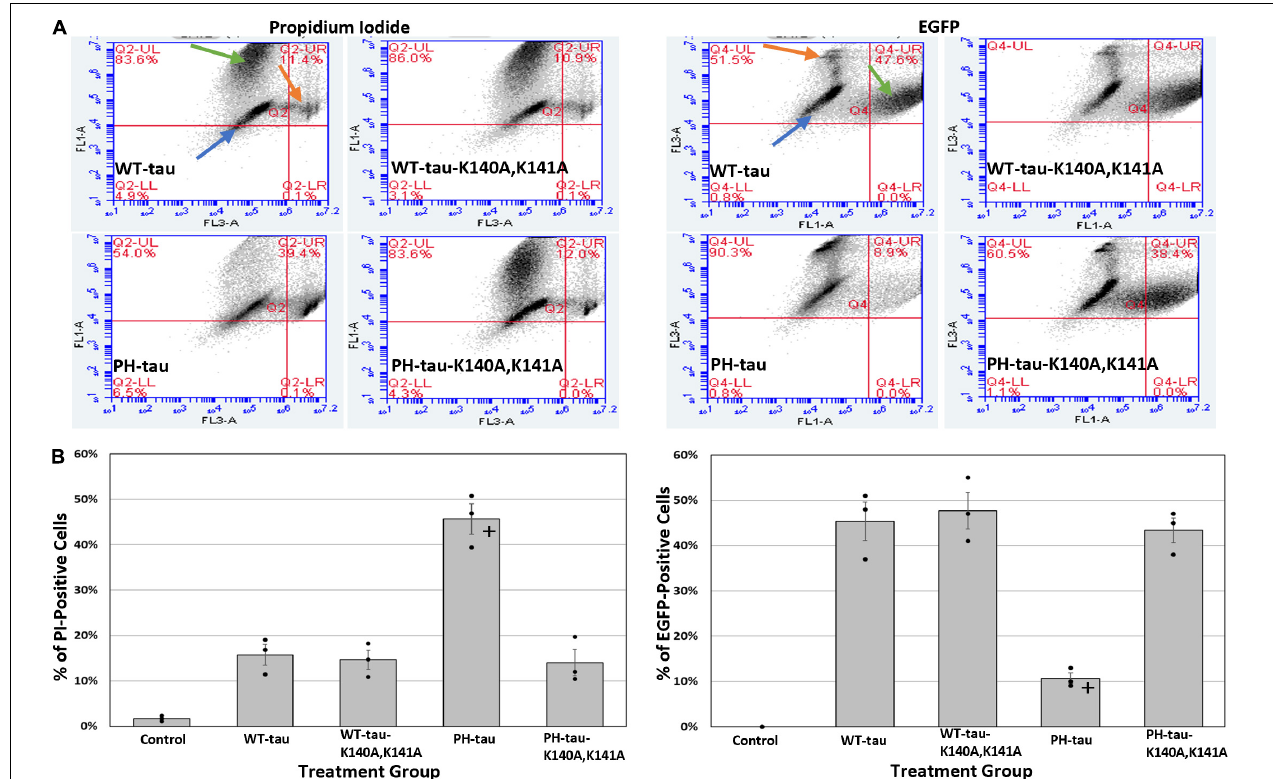
FIGURE 3 | Translocation of PH-tau into the nucleus promotes cell death. (A) Graphs indicating the percentage of cells that are PI-positive (left set of four) or EGFP-positive (right set of four) 24 h after transfection with WT-tau, PH-tau, WT-tau-K140A,K141A, or PH-tau-K140A,K141A. Orange arrows indicate the population of PI-positive cells, green arrows indicate the population of EGFP-positive cells, and blue arrows indicate the population of cells that is neither EGFP-positive nor PI-positive. (B) The percentage of events (i.e., cells) was extracted from the upper-right quadrant of each graph and plotted. The left graph shows the percentage of cells that are PI-positive, while the right graph shows the percentage of cells that are EGFP-positive (i.e., tau positive). The average percentage across all 3 replicates of this experiment are plotted as bars, with error bars indicating SEM. The bars are overlayed with a dot plot showing the individual average percentages from each replicate (n = 3). Data were analyzed using Welch’s ANOVA, and Games-Howell post-hoc test was used for pairwise comparisons. The + indicates a significant difference in PH-tau from all other groups, where p <